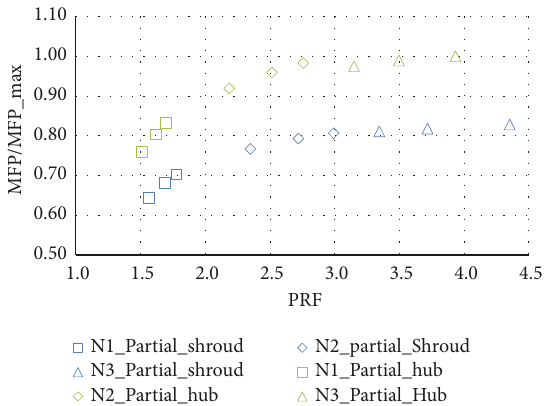
Figure 11: MFP (referred to maximum value) vs PRF, partial shroud (blue) and partial hub (green).